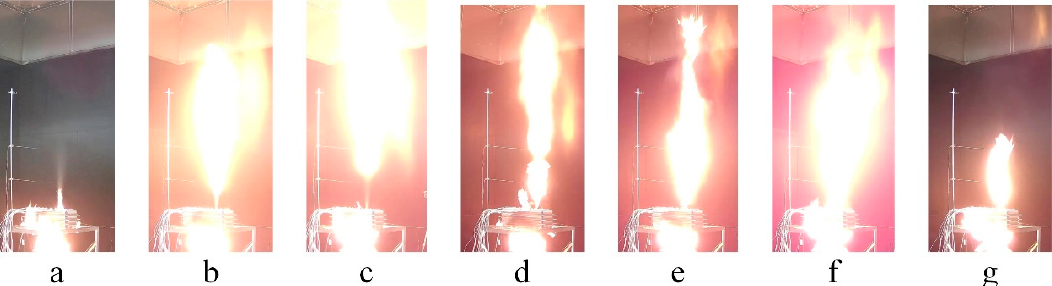
Figure 4. Combustion details of the safety valve rupturing process. ( a ) gas ejection; ( b , c ) gas ig- nited; ( d – f ) the first flame decreases and the second flame rises; ( g ) end of flame impact